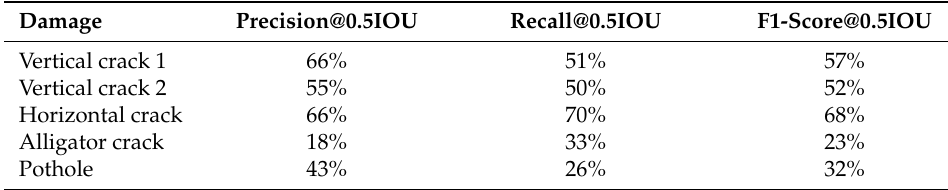
Table 3. Table for precision and recall Model 2.